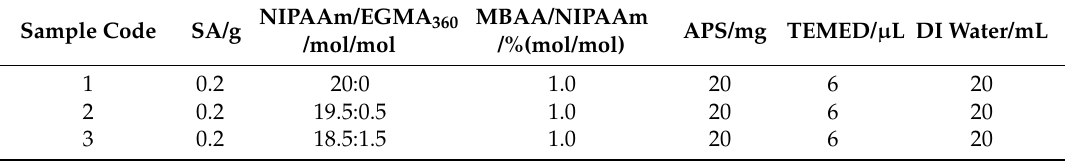
Table 1. Conditions for preparation of